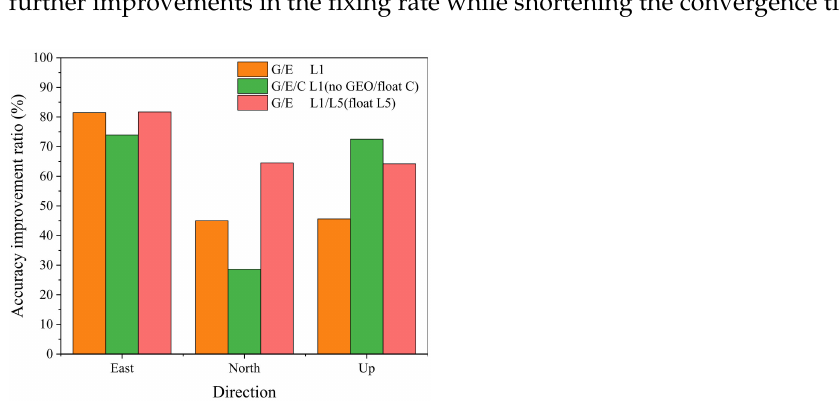
Figure 12. Accuracy of fixed solutions compared with corresponding float